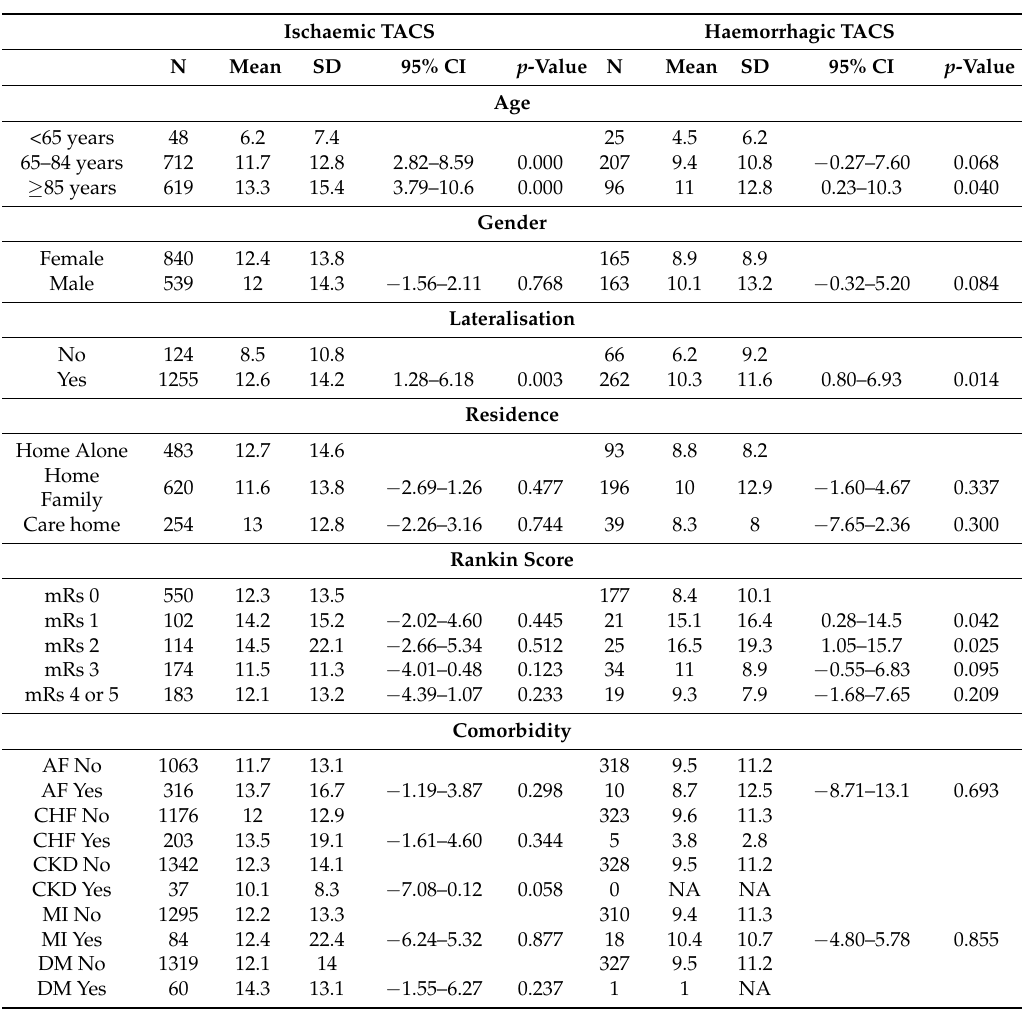
Table 4. Adjusted length of stay analysis with 95% confidence intervals of ischaemic and haemorrhagic TACS in patients who died during